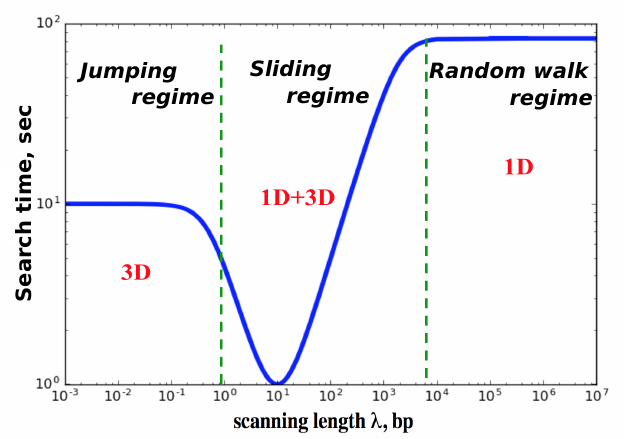
(cid:113) u / k of f .